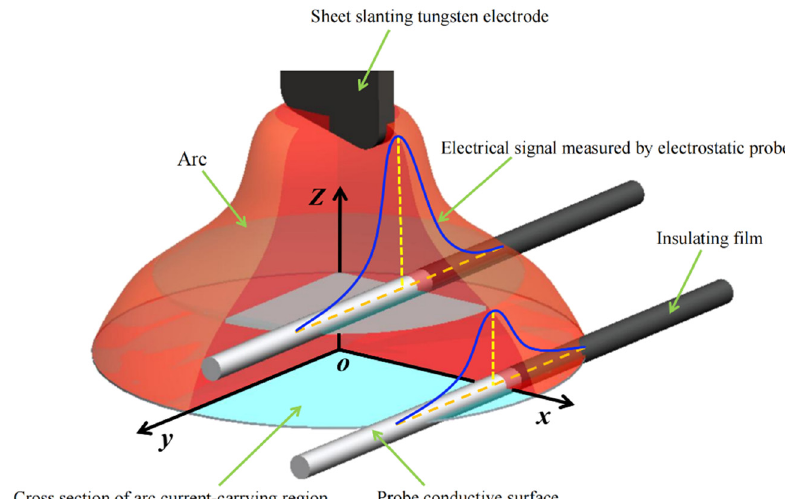
Figure 2: Electrostatic probe in the arc